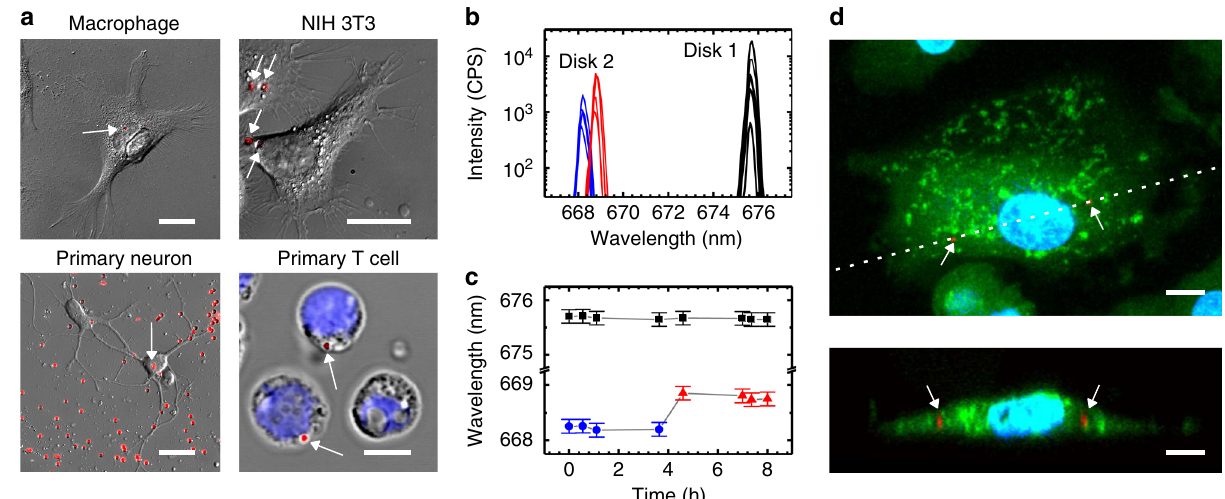
Fig. 3 Cellular uptake and lasing from semiconductor nanodisks. a Differential interference contrast (DIC) microscopy of primary human macrophage, NIH 3T3s, primary mouse neurons and primary human T cells with internalized nanodisks (overlaid red fl uorescence, indicated by white arrows). Nucleus of T cells labeled by blue Hoechst dye. b Laser spectra collected over period of 8 h for nanodisk inside a macrophage (Disk 1, black) and of a second disk that is internalized by the same cell during the experiment (Disk 2; blue before uptake, red after uptake). c Peak wavelength for spectra in ( b ) over time. Error bars indicate FWHM of spectra. d Laser scanning confocal fl uorescence microscopy image of fi xed macrophage with nanodisks (red fl uorescence, indicated by white arrows), nucleus in blue (Hoechst), and cytosol in green (Calcein-AM). Maximum intensity projection (top) and vertical cross-section along the dotted line in the top panel. All scale bars, 20 µ m; except for primary T cell, 5 µ